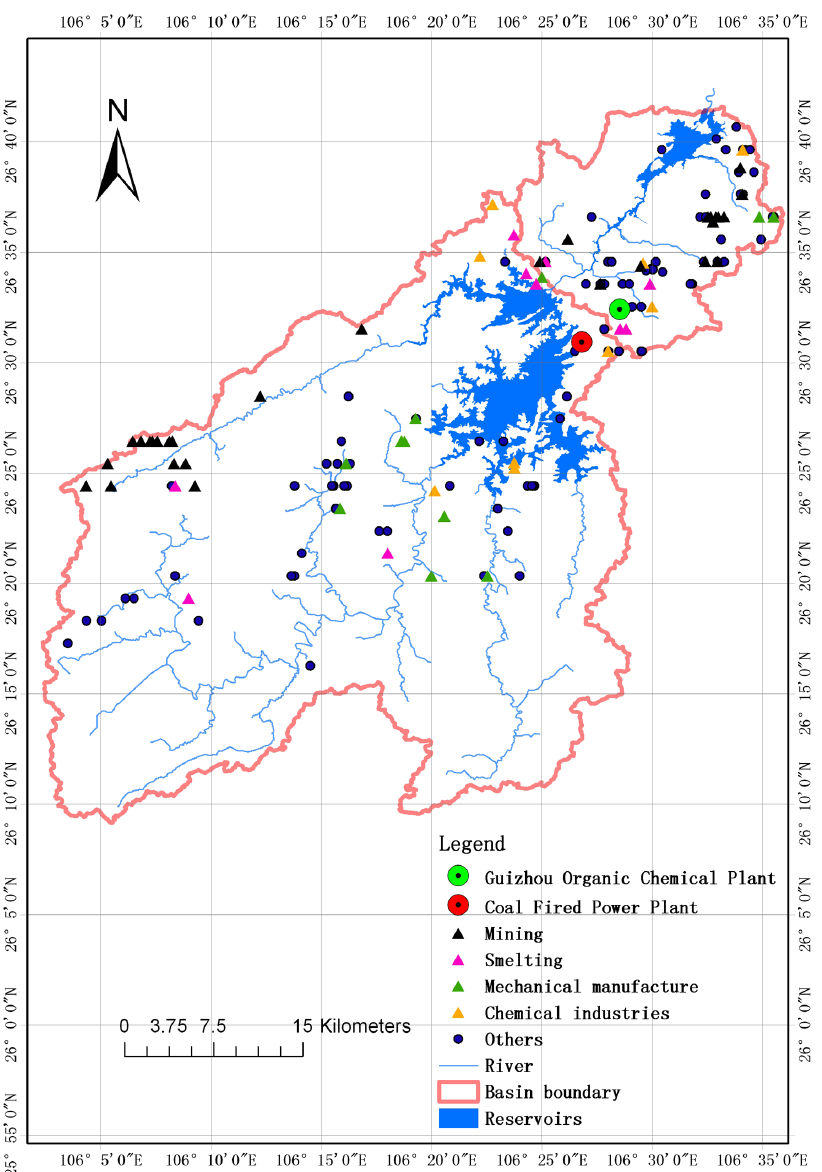
Figure 2. Distribution of main point sources of pollution in the Hongfeng and Baihua Reservoir basins.